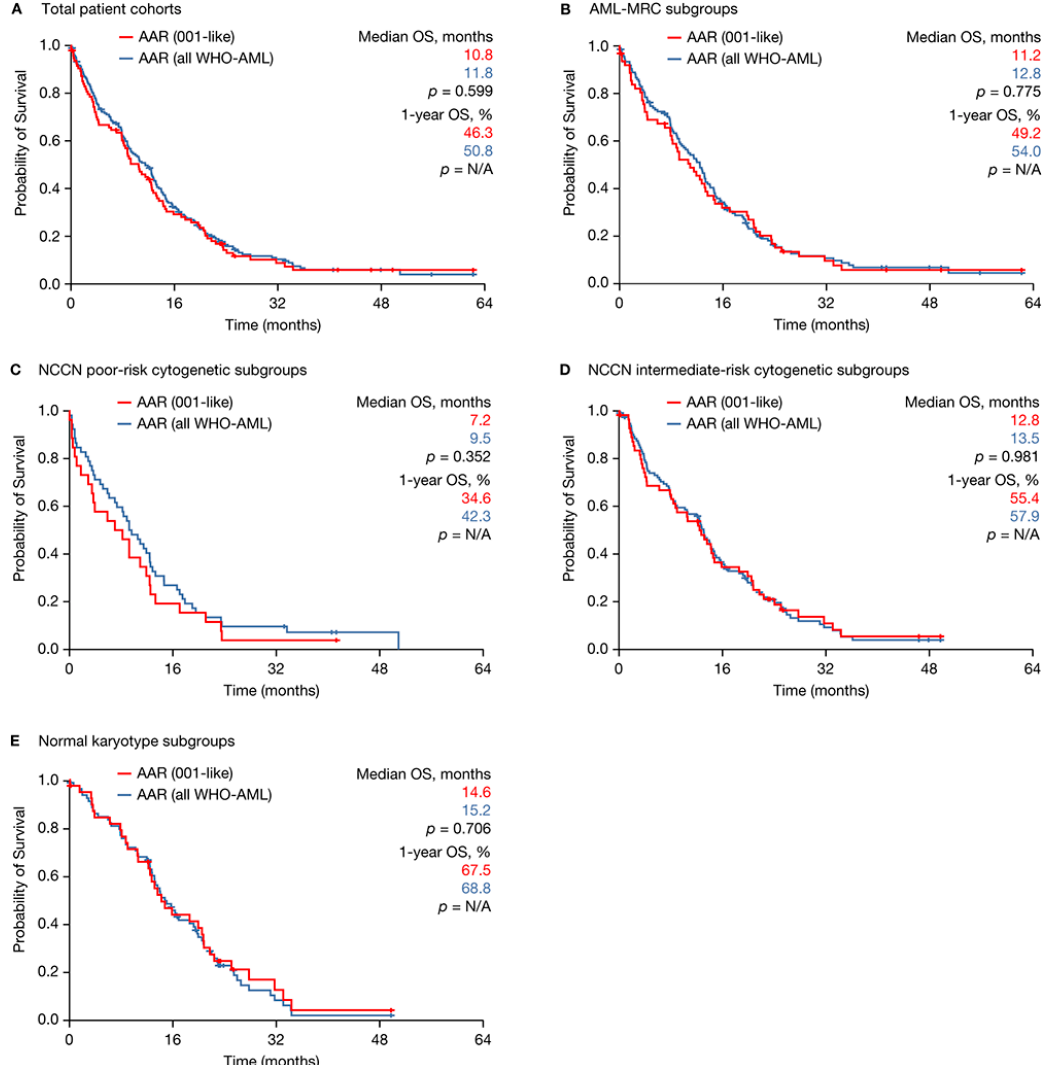
Figure 3. Median OS and one-year survival rates in AML patients with >30% BM blasts and <15 G/L WBC and WHO-AML patients treated with azacitidine front-line within the Austrian Azacitidine Registry. ( A ) Total patient cohorts; ( B ) AML-MRC; ( C ) AML with NCCN poor-risk cytogenetics; ( D ) AML with NCCN intermediate-risk cytogenetics; and ( E ) Normal karyotype.